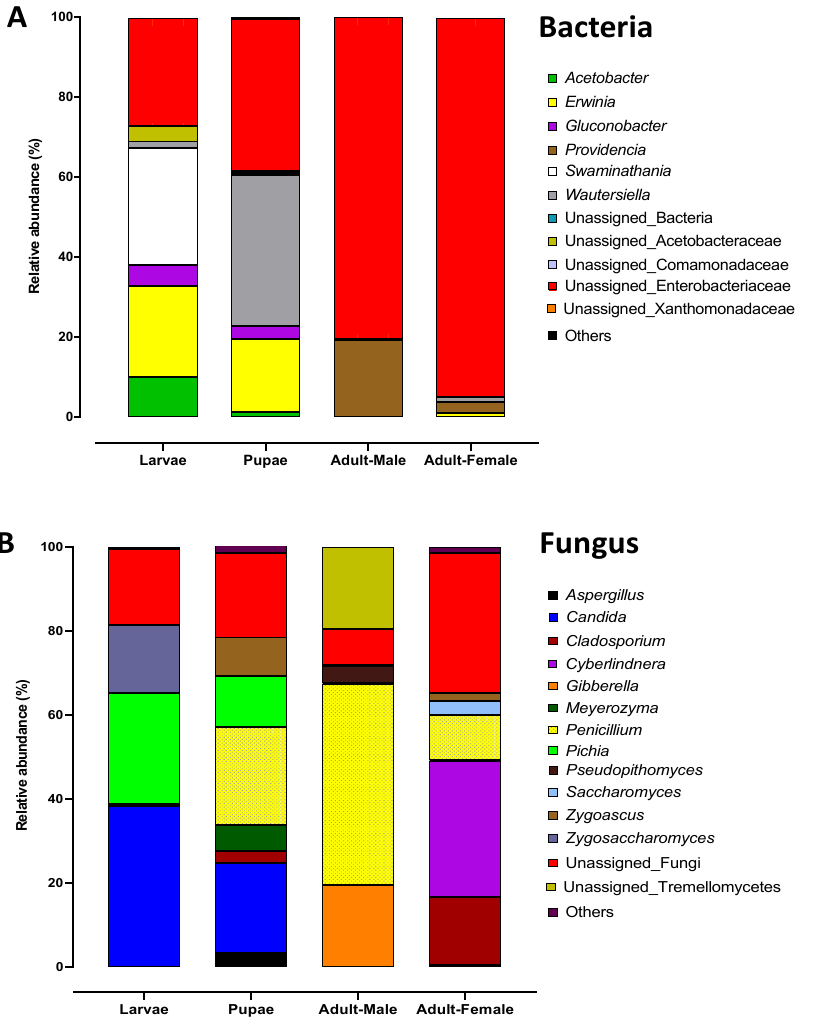
Figure 4. Relative abundance of the ( A ) bacterial and ( B ) fungal genus present in the different developmental stages of the Qfly.